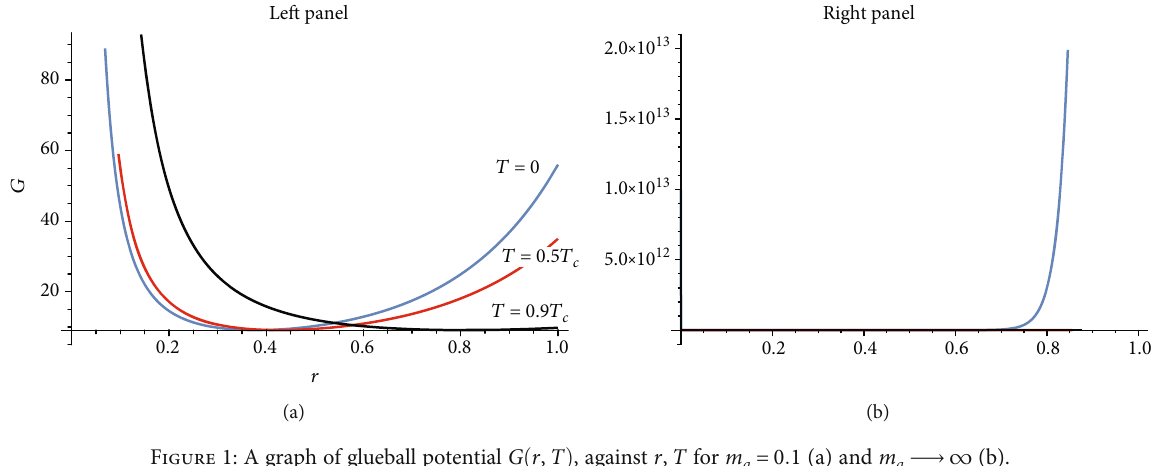
Figure 1: A graph of glueball potential G ð r , T Þ , against r , T for m